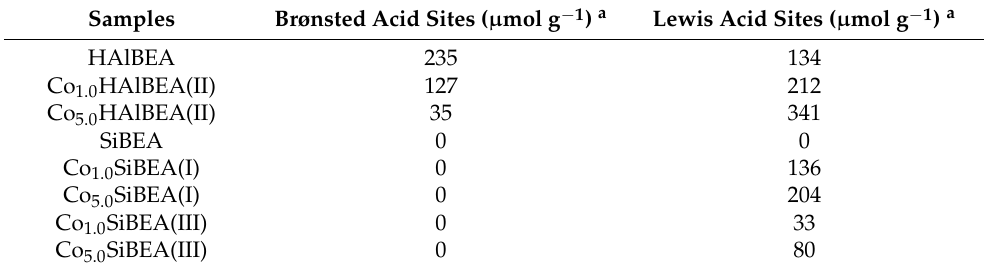
Table 1. The number of Brønsted and Lewis acid sites in HAlBEA, Co 1.0 HAlBEA(II), Co 5.0